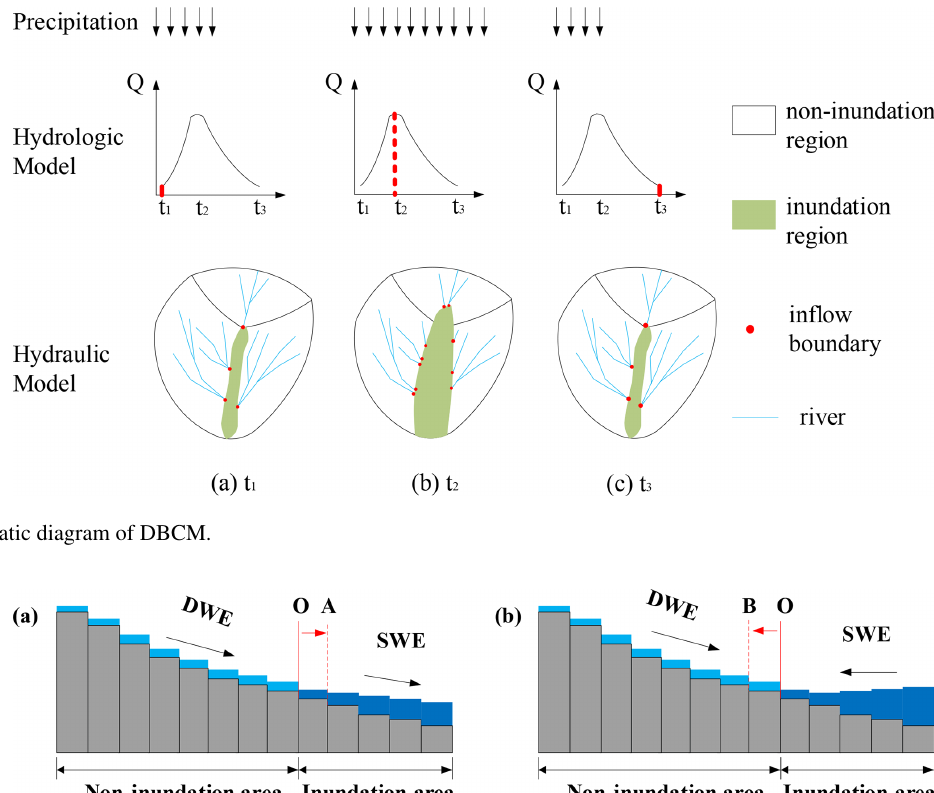
Figure 3. Flow state change and position of the coupling